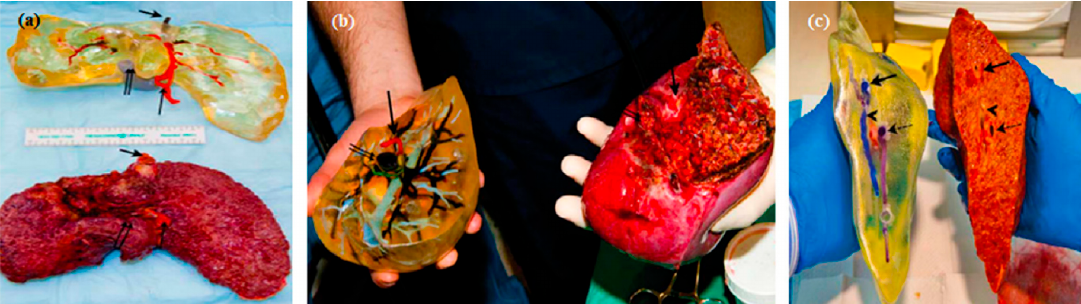
Figure 5. ( a ) Side view of a 3D printed liver and extracted liver of a patient, where long, short, and double arrows indicate hepatic artery, hepatic vein, and portal vein, respectively. ( b ) Right lobes of 3D printed and extracted livers with indications of the hepatic artery (single arrows) and portal vein (double arrows). ( c ) Cross-sectional views of 3D printed and extracted livers with indications of hepatic vein (single arrows) and portal vein (dotted arrows) [70].